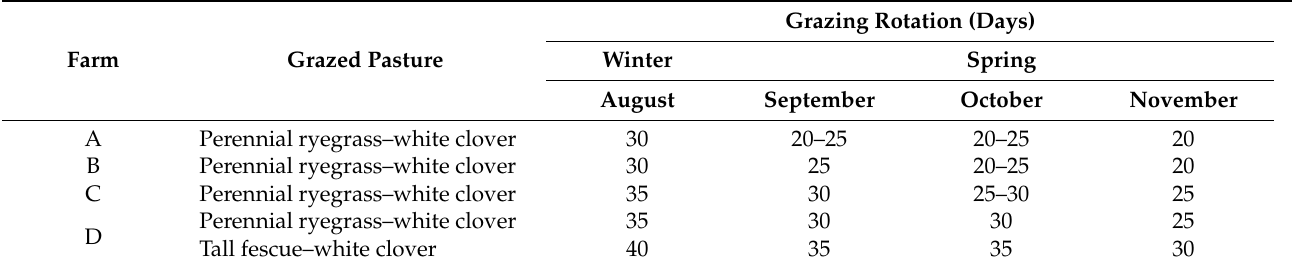
Table 1. The grazing rotation (days between grazing) of four dairy farms from August to November